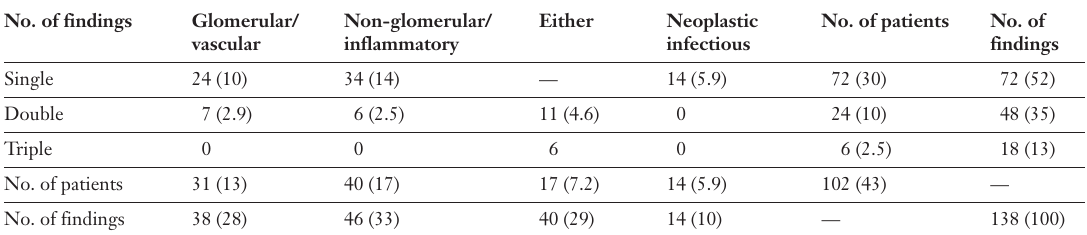
Number of patients with nephropatho- logical findings; listed by number and type of